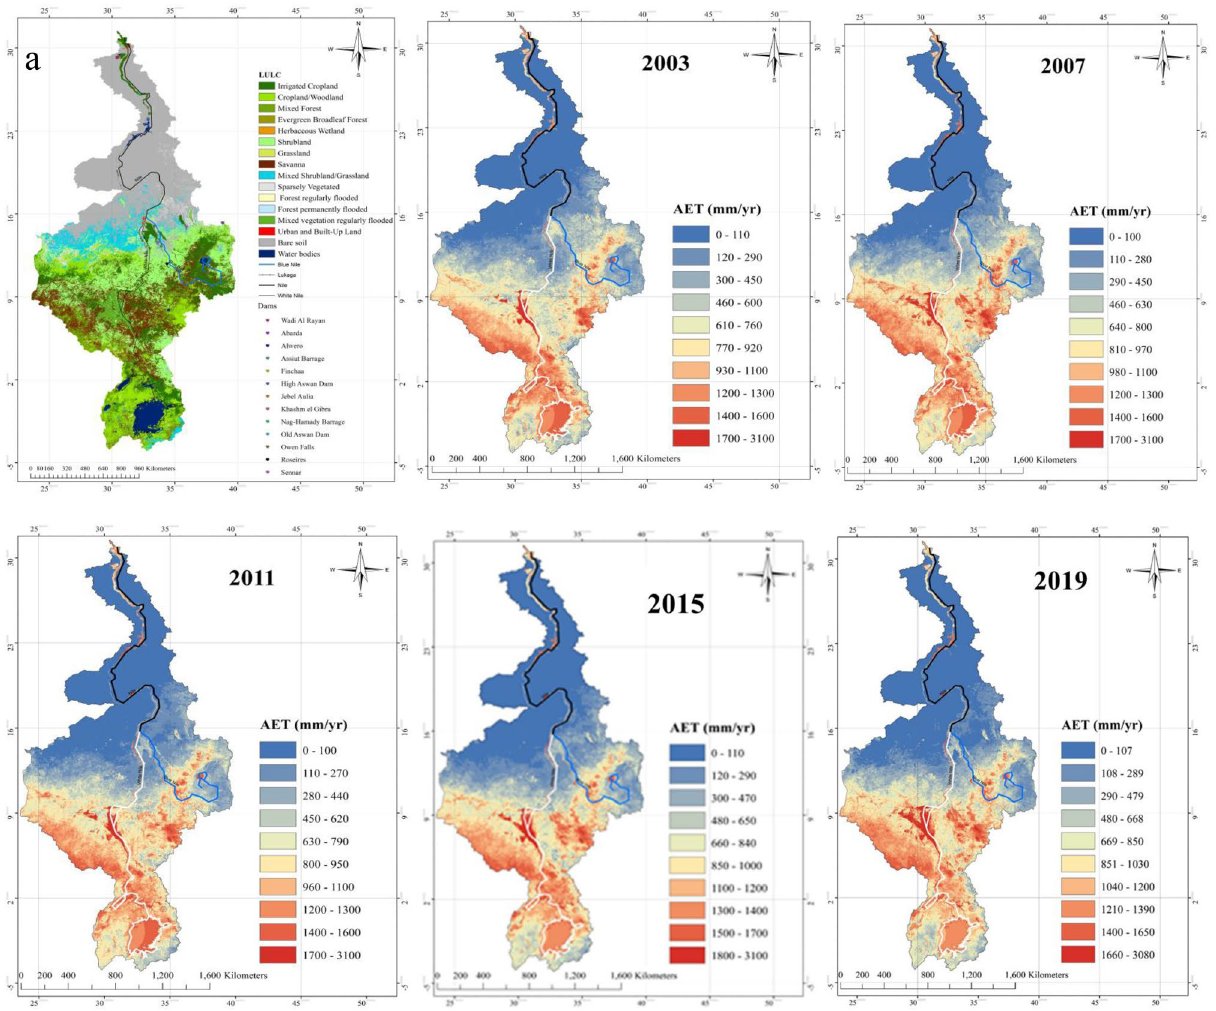
Figure 2. Spatial distribution of annual reference evapotranspiration ( a ), land cover ( b ), and AET (2003–2019). In ( a ) the average annual reference evapotranspiration for the NRB ranged from 746 to 2340 mm/year, with the highest values observed over Ethiopian highlands and the southern portion of the NRB in countries such as Uganda, Egypt, Sudan, Burundi, Congo, Kenya, Rwanda, and Tanzania. Our results also show that the NRB’s AET rates follow the rainy seasonal pattern. In ( b ) very high AET is observed in irrigated land and water bodies in these regions which lead to very high losses due to increased rate of AET. Figure 2 also shows that AET increases from year to year, this increasing trend expand to include other regions in the NRB. The maps were generated with ArcMap Version 10.1 (http:// www. esri. com/ en/ arcgis/ arcgis- for- deskt and significant coherence with ENSO, demonstrate a strong coupling between them, for both exhibited similar change patterns, e.g., positive IOD becomes more intensive as the strength of El Niño increases (supplementary Fig. 6). As a result, the impact of El Niño and IOD events in the hydroclimate of NRB have increased because of climate warming, which have contributed to the observed long-term trends in NRB’s hydroclimate since the 1970s. A wavelet coherence analysis (WTC) shows that the hydroclimate of NRB is strongly correlated with El Niño and IOD (supplementary Figs. 7 and 8). The strong WTC (anti-phase) between El Niño and IOD, and precipitation and RH after 1970s shows that El Niño and IOD had contributed to lower precipitation (drying) over NRB, and their significant in-phase relationship with surface temperature and GPH shows that stronger El Niño (El Niño3.4r) and IOD after 1970s resulted in a warmer NRB. In addition, WTC plots between AET and El Niño show in-phase, statistically significant coherent relationship at 2–4 and 8–14-years bands after 1970s (supplementary Fig. 9a, b), which peaked at 14–16-year time scale after 2000s. On the other hand, the WTC between IOD and AET show that IOD primarily lead AET after 2000s. Based on WTC and a detailed detrended cross correlation (ρ) analysis (DCCA), the hydroclimate of NRB is strongly teleconnected to El Niño and IOD (Fig. 4) at inter-annual to inter-decadal timescales, with positive or negative correlations between El Niño 3.4, surface temperature (ρ = 0.97) (Fig. 4a), GPH (ρ = 0.81) (Fig. 4b), RH (ρ = − 0.97) (Fig. 4c) and precipitation (ρ = − 0.7) (Fig. 4d).